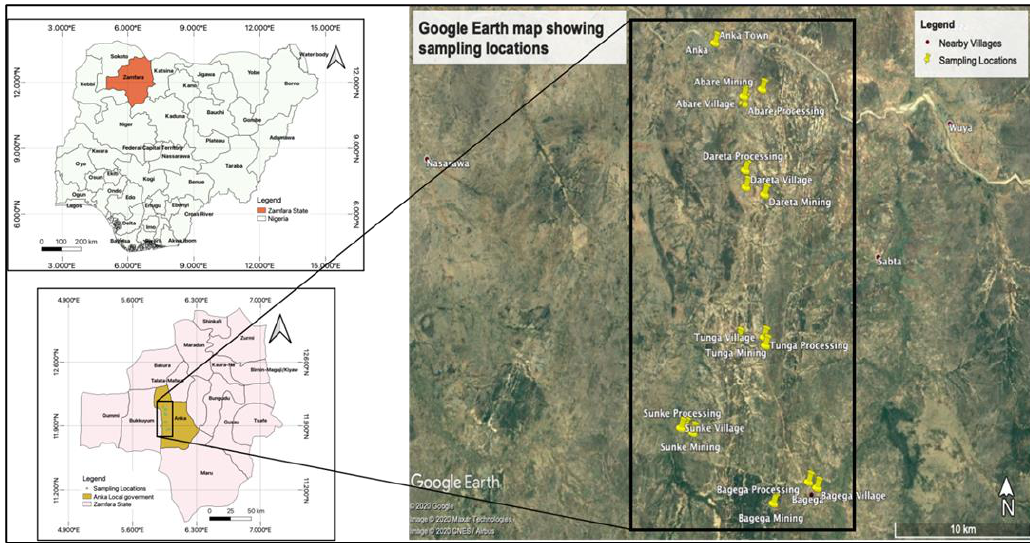
Figure 1. Map of Nigeria – Zamfara State – Anka Local government depicting the study locations Sample collection